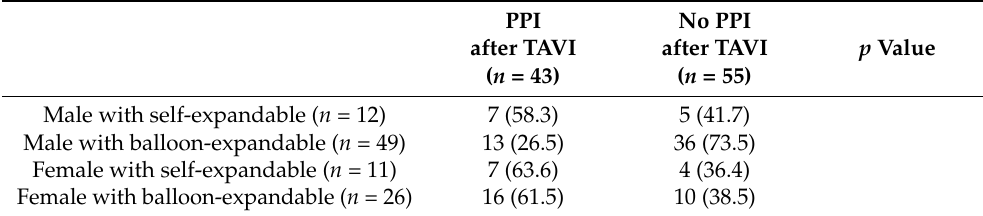
Distribution of PPI according to valve type and sex ( p for interaction =